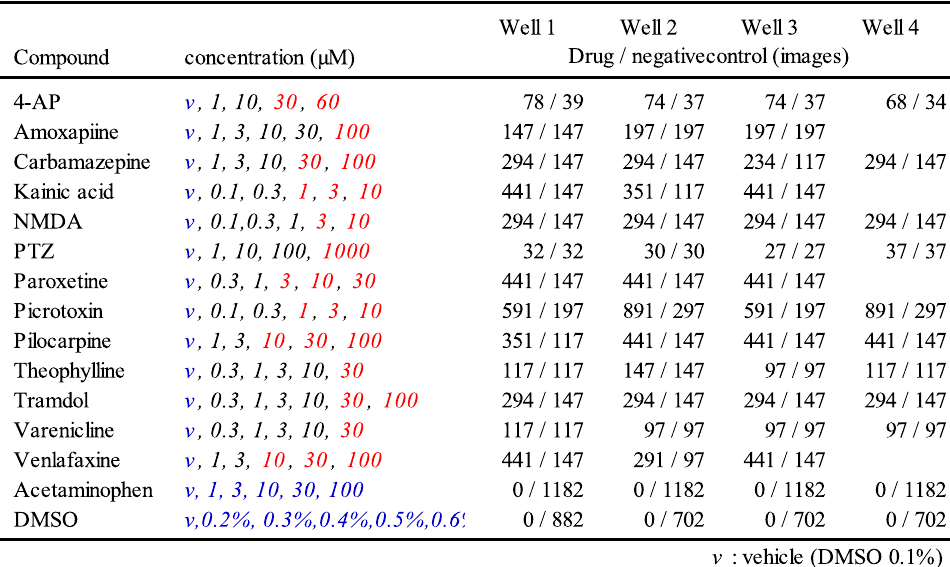
Table 3. Dataset information used for the creation of drug name prediction AI. The concentrations in red letters indicate the concentrations used for learning the drug name, and blue letters indicate the concentration learned as negative